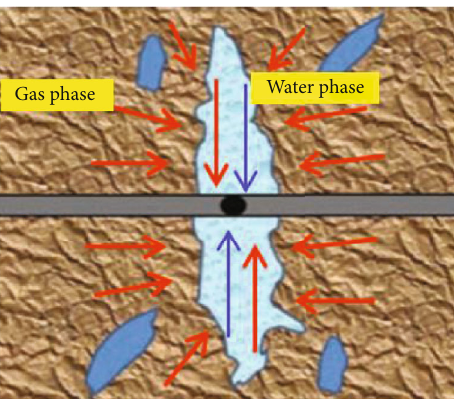
Figure 1: Schematic diagram of gas-water two-phase distribution in fl owback and early production stage.